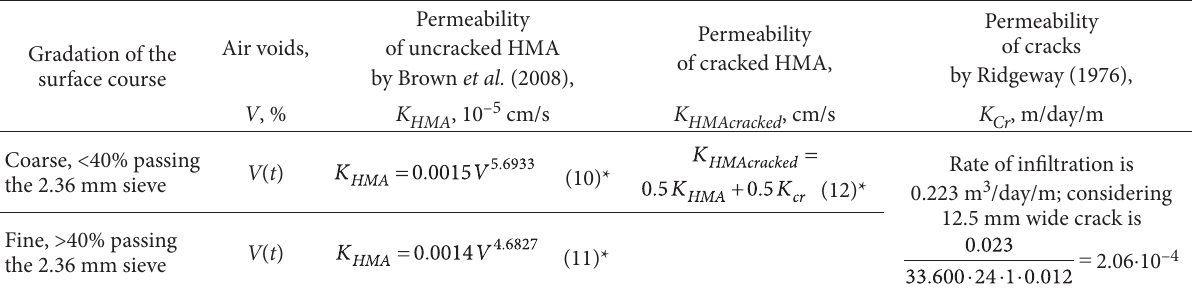
Table 2. Determination of K HMA and K HMAcracked Gradation of the surface course